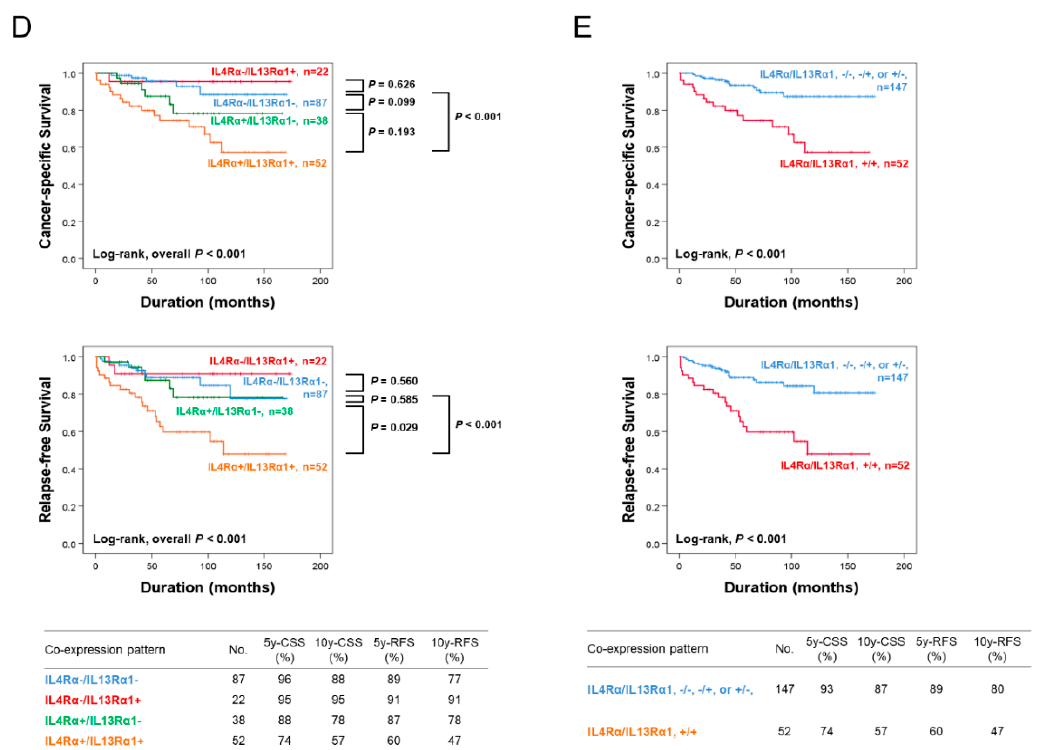
Figure 1. Immunohistochemical expression and survival analysis for the expression of interleukin4 receptor α (IL4R α ) and interleukin13 receptor α 1 (IL13R α 1) in clear cell renal cell carcinoma (CCRCC). ( A ) Immunohistochemical expression of IL4R α and IL13R α 1 in CCRCC tissue. Original magnification, ×400. ( B ) Analysis of sensitivity and specificity of the immunohistochemical staining score of IL4R α and IL13R α 1 in CCRCC for the event of cancer-specific survival (death of the patient by CCRCC) by receiver operator characteristic curves. The cutoff points were determined at the highest area under the curve (AUC). Red arrow indicates a cutoff point for the IL4R α immunostaining and blue arrowhead indicates a cut-off point for the IL13R α 1 immunostaining. ( C ) Kaplan-Meier survival analysis for cancer-specific survival and relapse-free survival according to the immunohistochemical positivity for IL4R α and IL13R α 1 in 199 CCRCC. ( D ) Kaplan-Meier survival analysis in IL4R α − / IL13R α 1 − , IL4R α − / IL13R α 1 + , IL4R α +/ IL13R α 1 − , and IL4R α +/ IL13R α 1 + subgroups according to the positivity for IL4R α and IL13R α 1 expressions. ( E ) Kaplan-Meier survival analysis in two subgroups according to the co-expression patterns of IL4R α and IL13R α 1; favorable (IL4R α − / IL13R α 1 − , IL4R α − / IL13R α 1 + , or IL4R α +/ IL13R α 1 − ) and poor prognostic (IL4R α +/ IL13R α 1 + ) subgroups. 5y-cancer-specific survival (CSS); 5-year cancer-specific survival rate, 10y-CSS; 10-year cancer-specific survival rate; 5y-RFS; five-year relapse-free survival rate, 10y- relapse-free survival (RFS); 10-year relapse-free survival rate. Table 1. Clinicopathologic variables and the expression of interleukin4 receptor α (IL4R α ) and interleukin13 receptor α 1 (IL13R α 1) in clear cell renal cell carcinoma (CCRCC) patients.